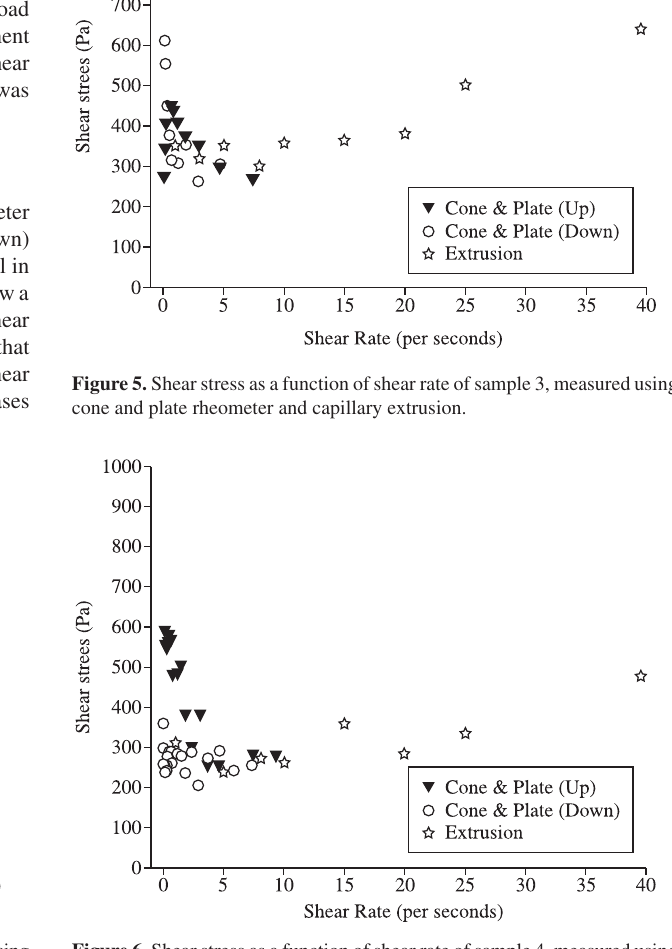
Figure 6. Shear stress as a function of shear rate of sample 4, measured using cone and plate rheometer and capillary